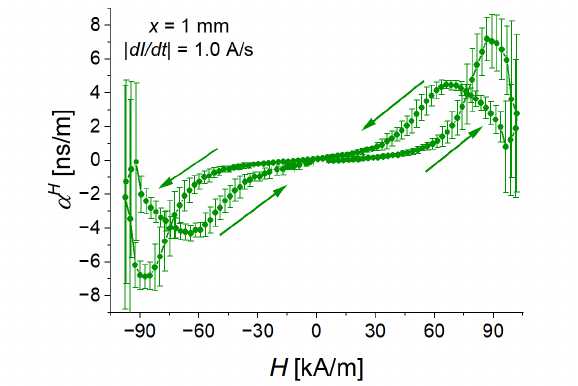
Figure 4. Dependence of the magnetoelectric coupling coefficient for x = 1 mm and a slew rate of 53 kA/sm on the applied magnetic field strength. Here and in the following Figures, the arrows designate the direction of magnetic-field